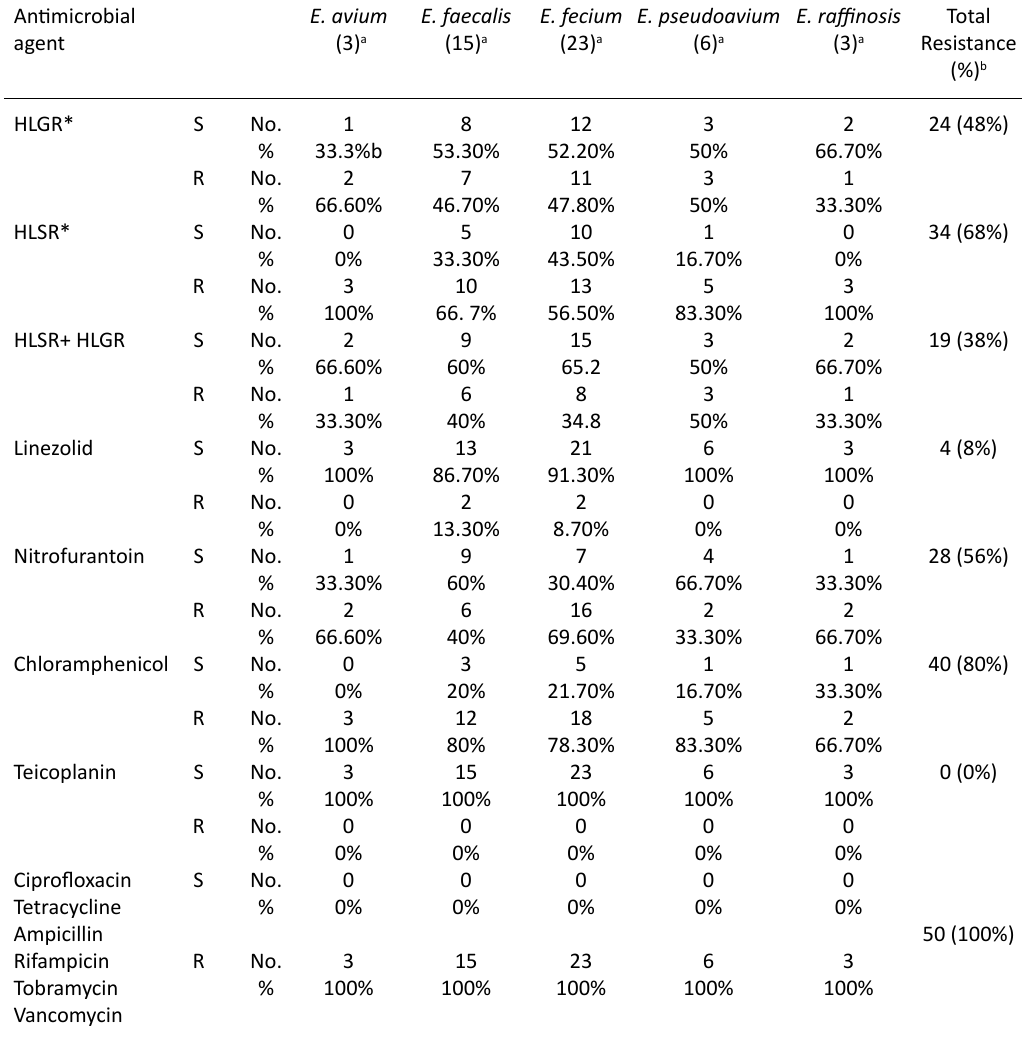
Table 2. Antimicrobial susceptibility patterns of the isolated Enterococcus spp. Antimicrobial E. avium E. faecalis E. fecium E. pseudoavium E.